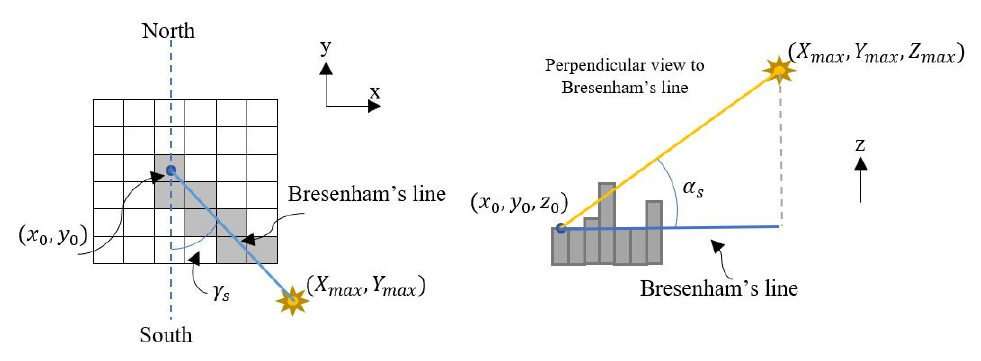
Figure A1. The Bresenham’s line schematic for the shaded pixels.